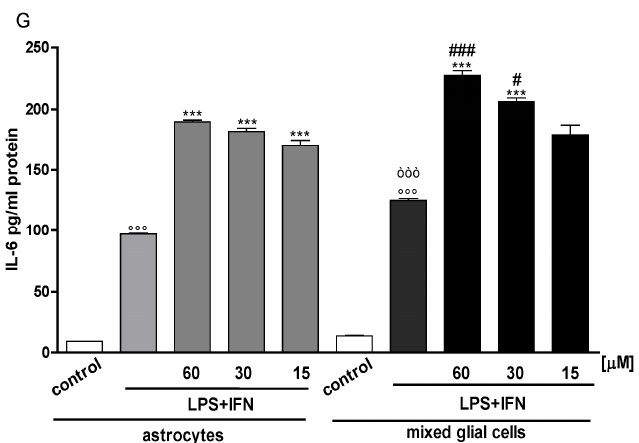
Figure 3. Effect of IS (60, 30 and 15 µM) in inflammatory conditions, induced by LPS (1 µg/mL) + IFN (100 U/mL), on NO relase ( Panel A ), evaluated as NO 2 [µM]. Effect of IS (15–60 µM) in presence of LPS (1 µg/mL) + IFN (100 U/mL) on iNOS ( Panel B ), and COX-2 ( Panel D ) expression in primary astrocytes and mixed glial cells. Cellular fluorescence was evaluated using fluorescence-activated cell sorting analysis (FACSscan; Becton Dickinson), and elaborated with Cell Quest software. Panel C shows the representative fluorescence images for iNOS expression (for primary astrocytes the pink line represent the cellular control, the blue line represent LPS + IFN, the yellow line represent IS 30 µM + LPS + IFN; for mixed glial cells the violet line represent the cellular control, the light blue line represent LPS + IFN, the orange line represent IS 30 µM + LPS + IFN). Panel E shows the representative fluorescence images for COX-2 expression (for primary astrocytes the pink line represent the cellular control, the blue line represent LPS + IFN, the yellow line represent IS 30 µM with LPS + IFN; for mixed glial cells the violet line represent the cellular control, the light blue line represent LPS + IFN, the orange line represent IS 30 µM with LPS + IFN. Effect of IS (15, 30, and 60 µM) in inflammatory conditions, induced by LPS (1 µg/mL) and IFN (100 U/mL) on TNF- α ( Panel F ) and on IL-6 ( Panel G ) release by astrocytes and mixed glial cells. Cyokine release was assessed by ELISA assay. Values are expressed as NO 2- release, or mean fluorescence intensity or as pg/mL protein for cytokines. Comparisons were performed using a one-way analysis of variance and multiple comparisons were made by Bonferroni’s post test. °°° denotes p < 0.001 vs. control. ***, ** denote p < 0.001 and p < 0.01 vs. LPS + IFN. òòò, òò, ò denote p < 0.001, p < 0.01 and p < 005 vs. astrocytes treated with LPS + IFN. ### , # denote p < 0.001 and p < 0.05 vs. astrocytes treated with IS andLPS + IFN.